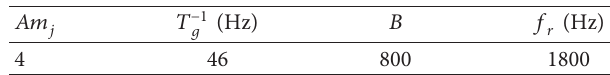
Figure 4: The flowchart of ALIF-SBAKW. Table 1: Parameters of signal I ( t )